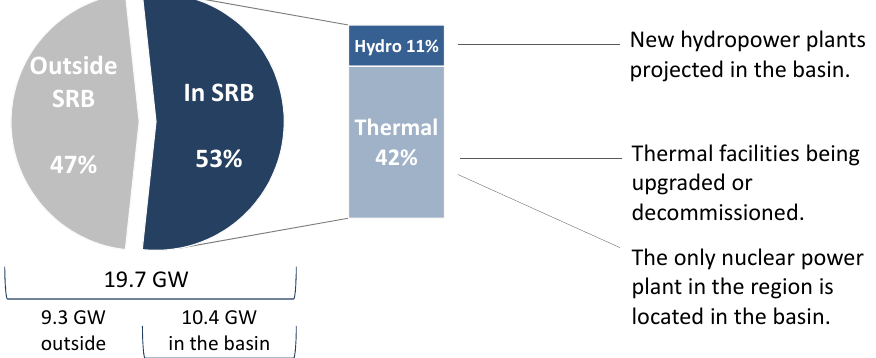
Figure A3 . Installed capacity in the region in 2012 Figure A3. Installed capacity in the region in